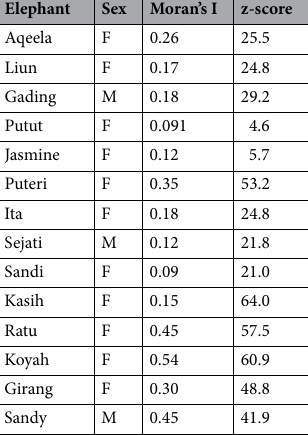
Table 2. The summary of Moran’s I autocorrelation coefficient analysis for elephant collared data of 14 individuals. All p values were <